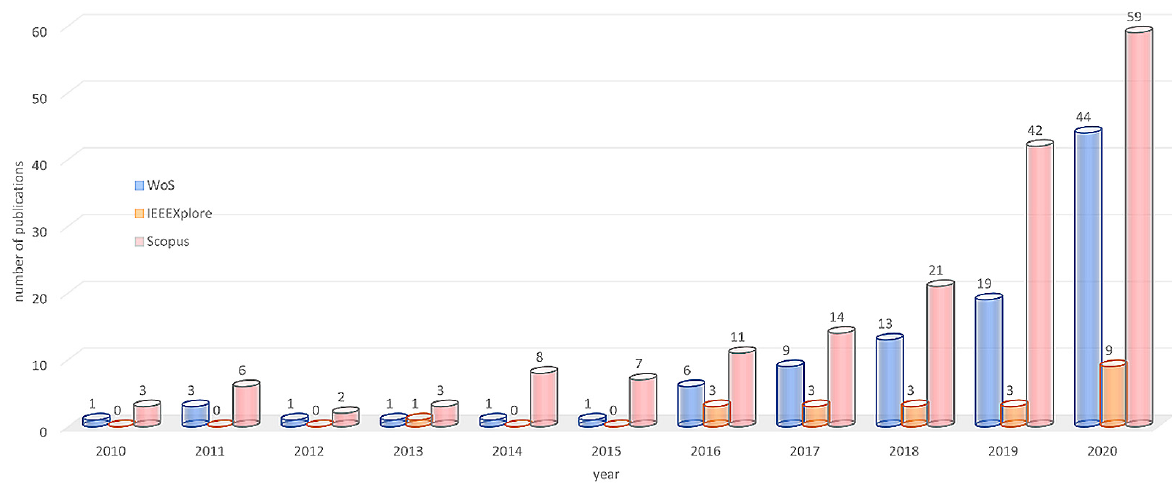
Figure 2. The number of publications between 2010 and 2020 ( n =